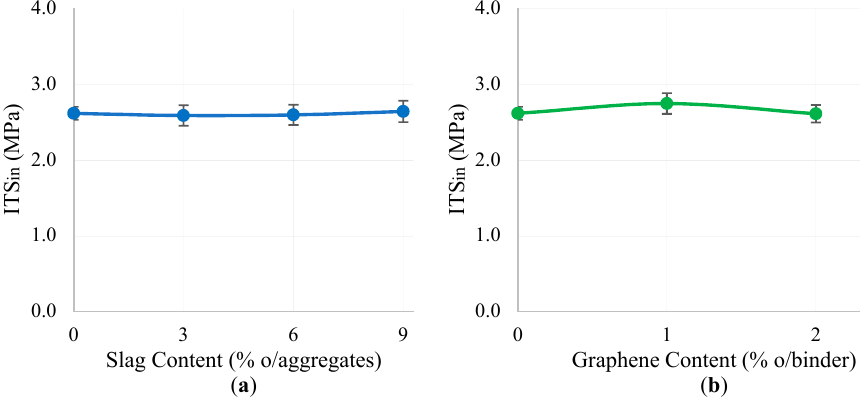
Figure 10. Effect of slag ( a ) and graphene ( b ) on the Indirect Tensile Strength ITS in .